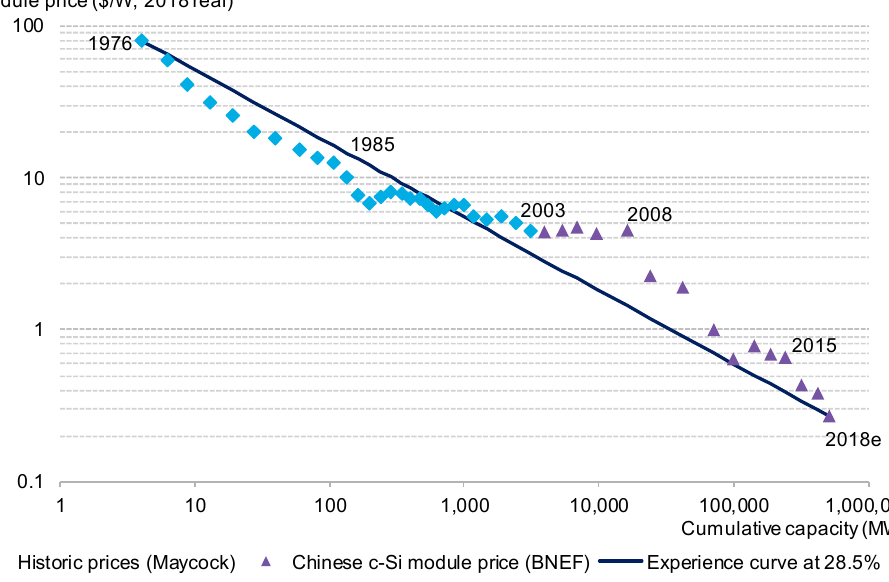
Figure 1. Learning rate of crystalline silicon modules.